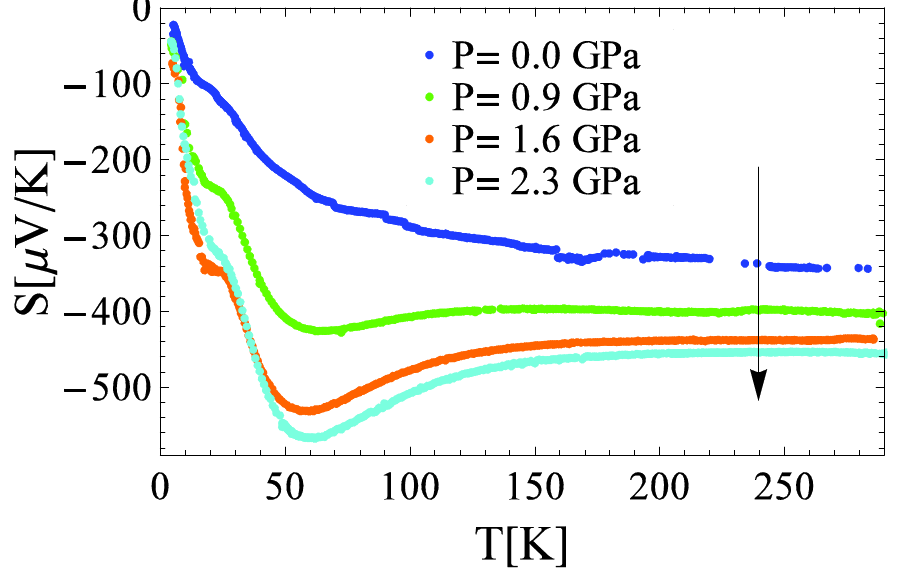
Figure 3. Temperature dependence of the thermo-electric power shown at various